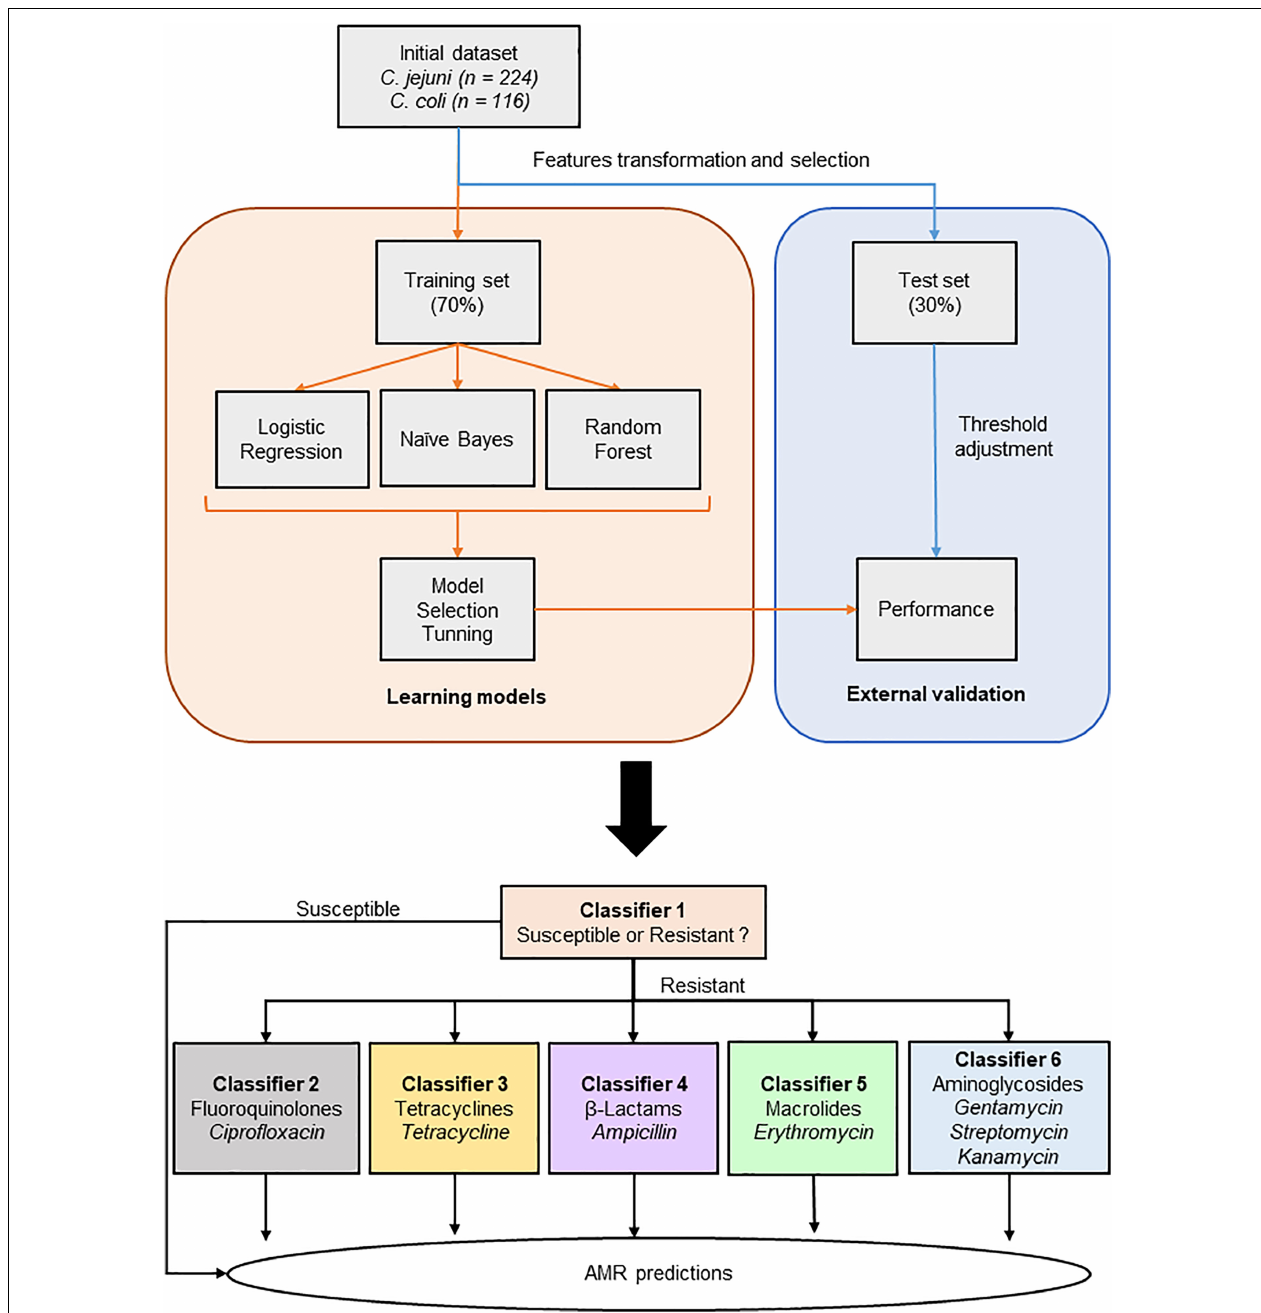
FIGURE 1 | Schematic overview of the machine learning workflow.